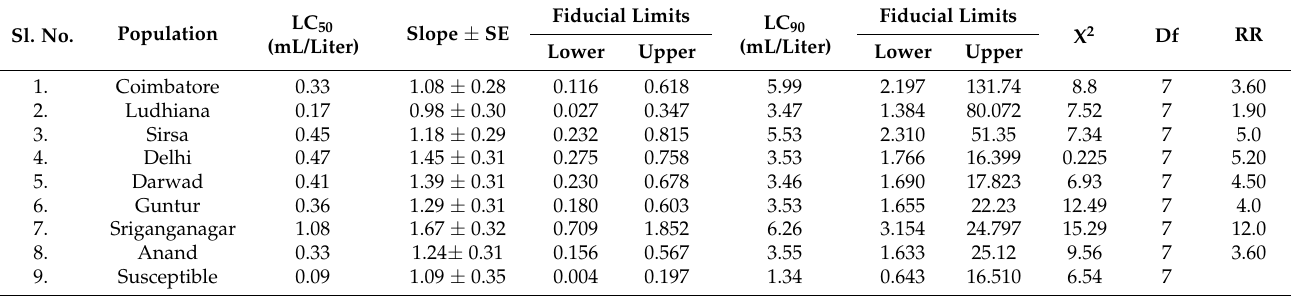
Table 1. Dose-mortality of different field populations of CZS against imidacloprid 17.8 SL.